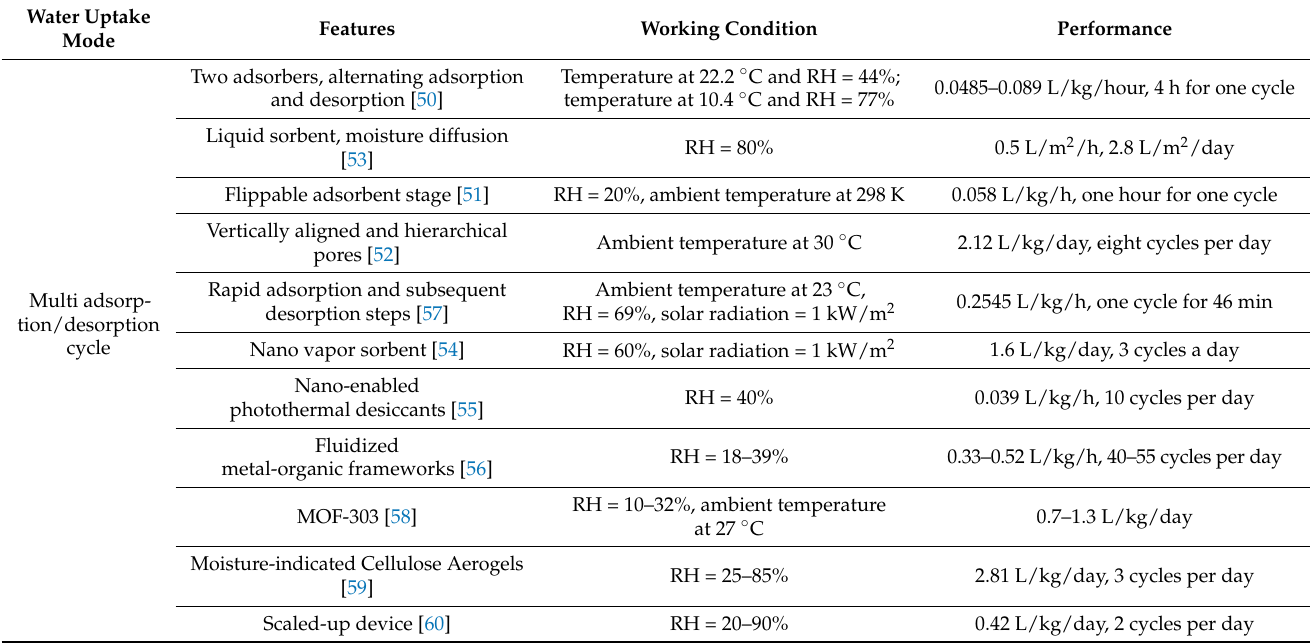
Table 2. Features and parameters of selected atmospheric water harvesting systems with multi- adsorption-desorption